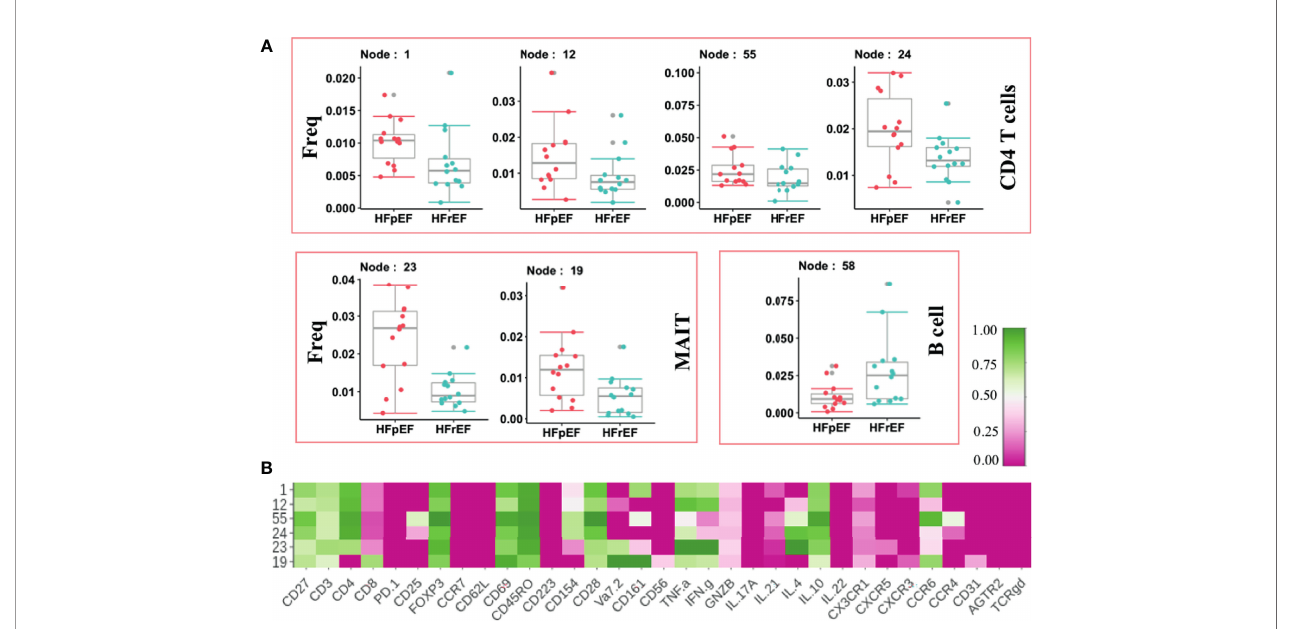
FIGURE 4 | Immune cells modulated in Heart Failure cases categorized on the basis of left ventricular ejection fraction. (A) Frequency of signi fi cantly modulated Immune cell subset in patients with Heart Failure with preserved ejection fraction [HFpEF(n=14)] compared to Heart Failure patients with reduced ejection fraction [HFrEF(n=14)]. Frequency of signi fi cantly altered cell subsets is shown as box and whisker plots. (B) Phenotypes of the signi fi cantly altered immune subsets is shown as heatmap. Normalize median intensity of each marker used to plot